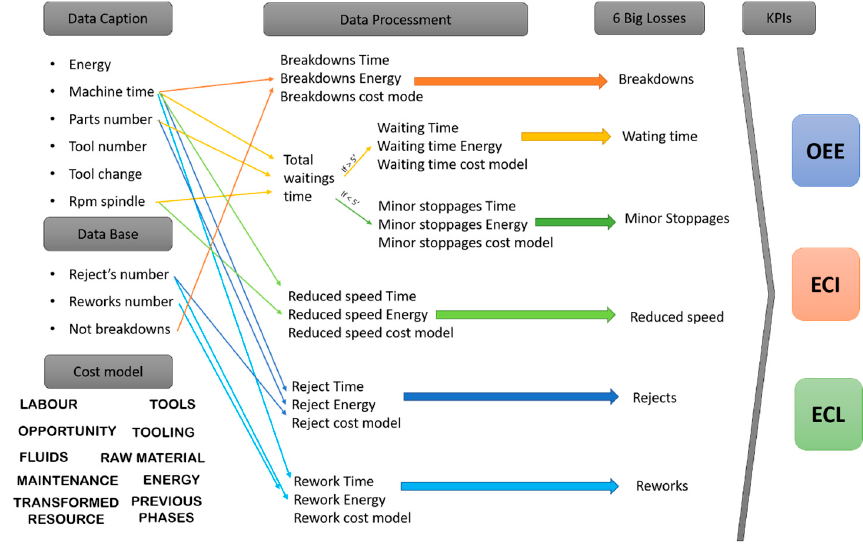
Figure 4. Flow chart for Key Performance Indicators (KPIs) implementation in CPS. Reference [27].